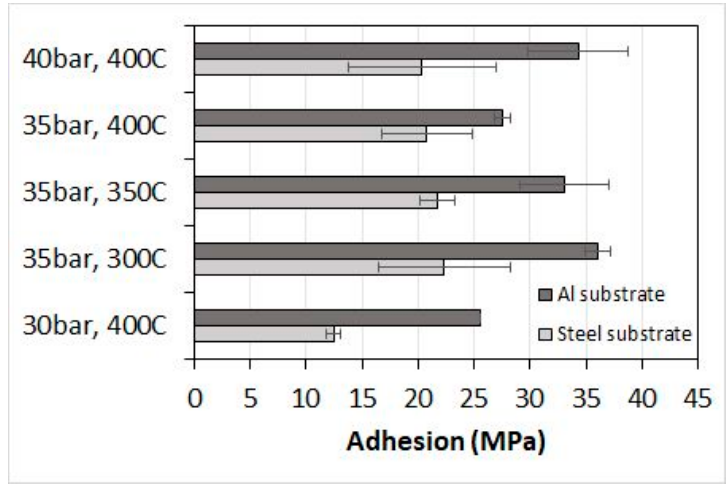
Figure 10. Adhesion strengths of the cold-sprayed Al6061 coatings sprayed with different spray parameters on grit-blasted Al and steel substrates.